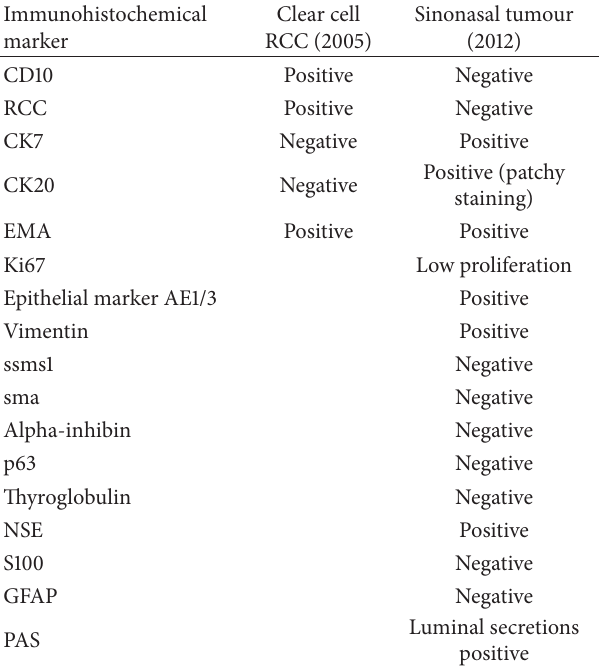
Table 1: Immunohistochemical profile of the renal and sinonasal